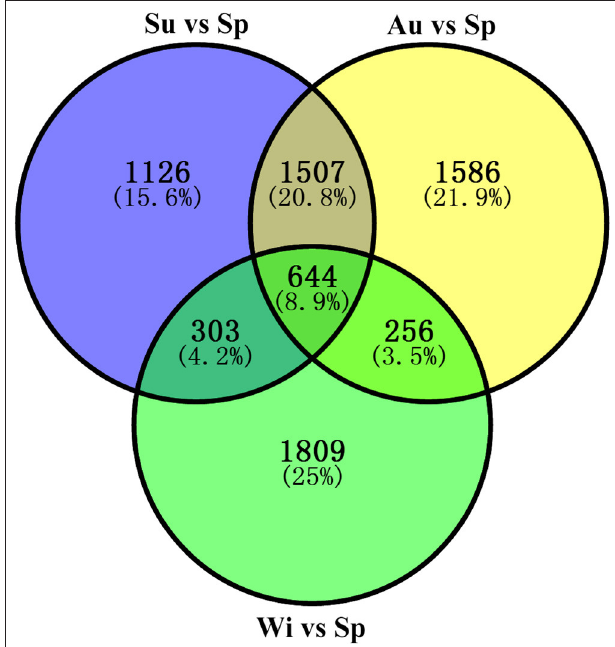
FIGURE 5 | A Venn diagram showing the distribution of differentially expressed genes (DEGs) in Su, Au, and Wi samples by comparing with the Sp sample in T. hemsleyanum